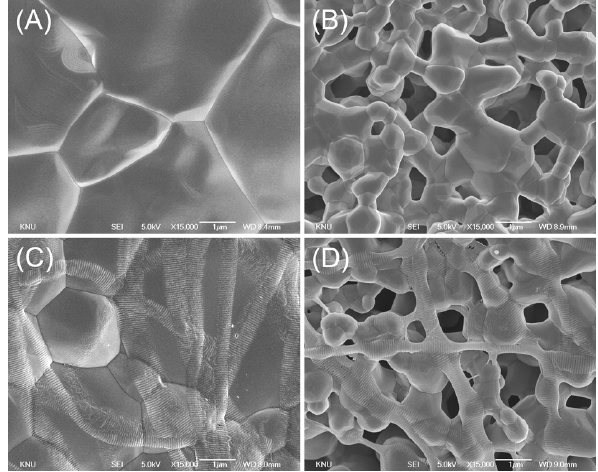
Figure 1. SEM images of scaffold microstructure (15,000×, bar = 1 μ m); ( A ) Control; ( B ) micropore (MP); ( C ) collagen (COL); ( D ) micropore/collagen-combined